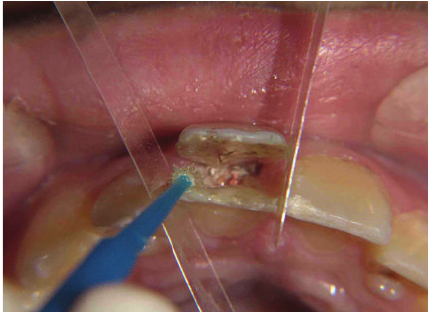
Figure 5: Application of adhesive